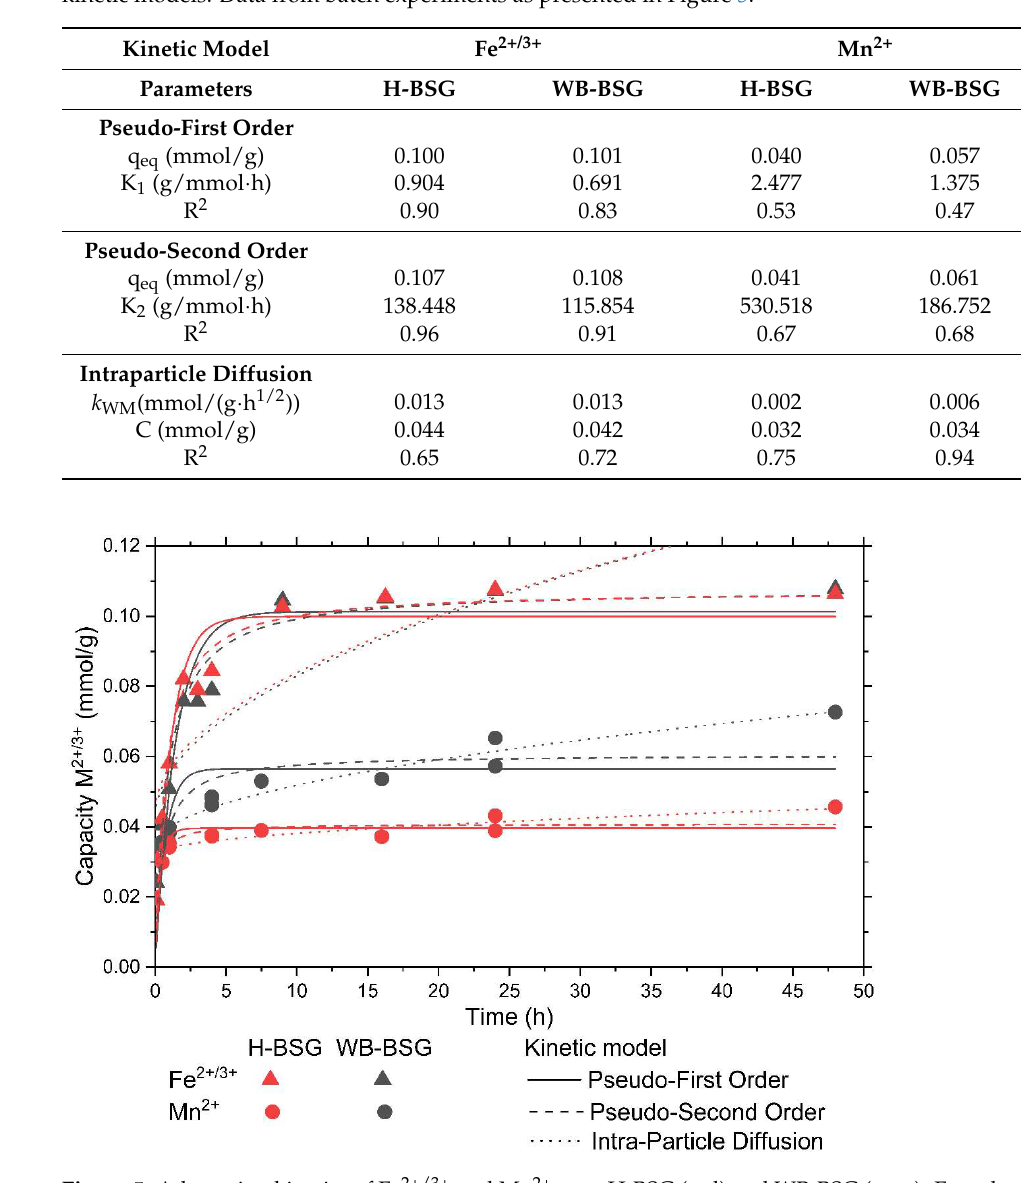
Figure 5. Adsorption kinetics of Fe 2+/3+ and Mn 2+ onto H-BSG (red) and WB-BSG (grey). From batch experiments with c 0 = 0.36 mmol/L Fe 2+/3+ or Mn 2+ , a BSG dosage of 3.33 g/L, stirred at r.t. and measured at respective times. Curves present respective fitted kinetic models, model parameters given in Table 3. The respective pH values are given in Figure S6. Table 3. Fitting parameters for Fe 2+/3+ and Mn 2+ adsorption onto H-BSG and WB-BSG for different kinetic models. Data from batch experiments as presented in Figure 5.